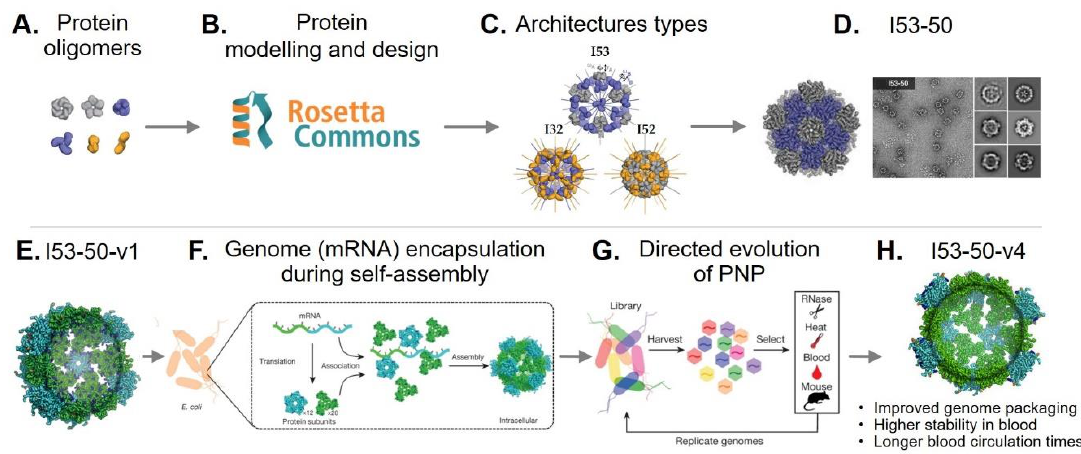
Figure 1. Rational design and directed evolution of a synthetic nucleocapsid. ( Upper panel ) Diagram showing the in silico design process and subsequent production of a de novo PNP. ( A ) Pentameric (gray), trimeric (blue), and dimeric (yellow) protein oligomers selected for rational design. ( B ) The Rosetta software was employed in the in silico design of new PNPs. ( C ) Rosetta-predicted PNP architecture types. ( D ) Design model I53-50 and its corresponding negative-stain electron micrograph, showing that the obtained structure matched the predicted in silico model. Adapted with permission of [80]. ( Lower panel ) Synthetic nucleocapsid design and evolution. ( E ) Model of the I53-50-v1. Pentamers (cyan) and trimers (green). ( F ) Nucleocapsids are capable of encapsulating their own genome (mRNA) during self-assembly in Escherichia coli. ( G ) E. coli is transformed with a library of synthetic nucleocapsid variants. All variants are purified together from cell lysates and selected against RNase, heat, blood, and in vivo blood circulation. The mRNA inside the selected capsids variants is then obtained and amplified using quantitative reverse transcription PCR (RT-qPCR), re-cloned to construct a new library, and transformed into E. coli for another round of selection. ( H ) After several rounds of evolution, an improved version of the original nucleocapsid was obtained (I53-50-v4). Adapted with permission of [81].